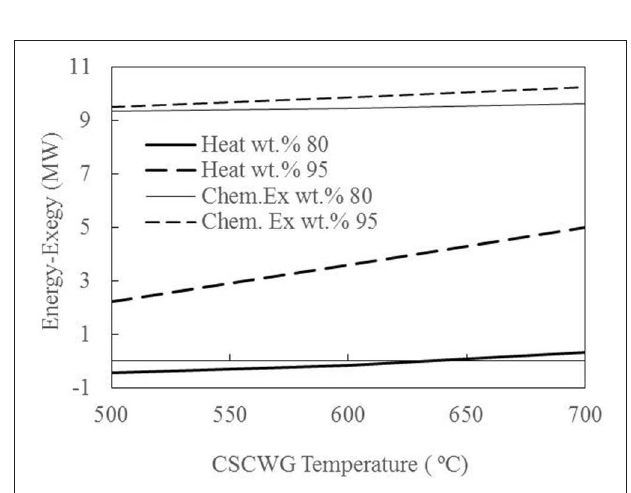
FIGURE 9 | Supercritical water gasification (SCWG) heat needed and chemical exergy of stream SYNGAS as a function of the gasifier